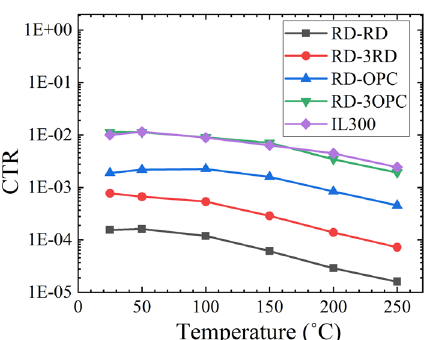
Figure 7. CTR of optocouplers with varying